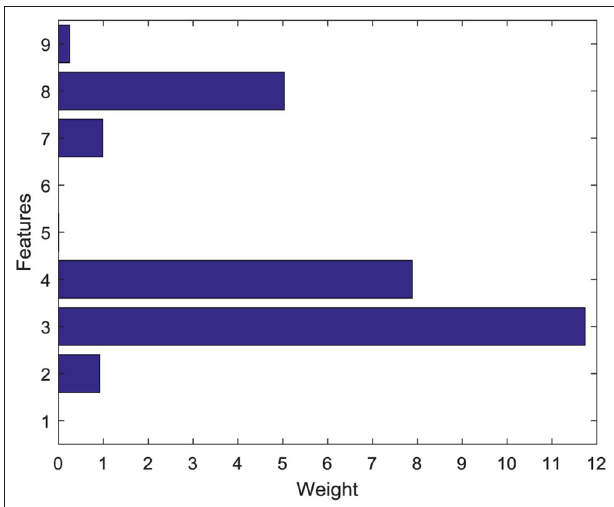
FIGURE 6 | Weight values of different features.